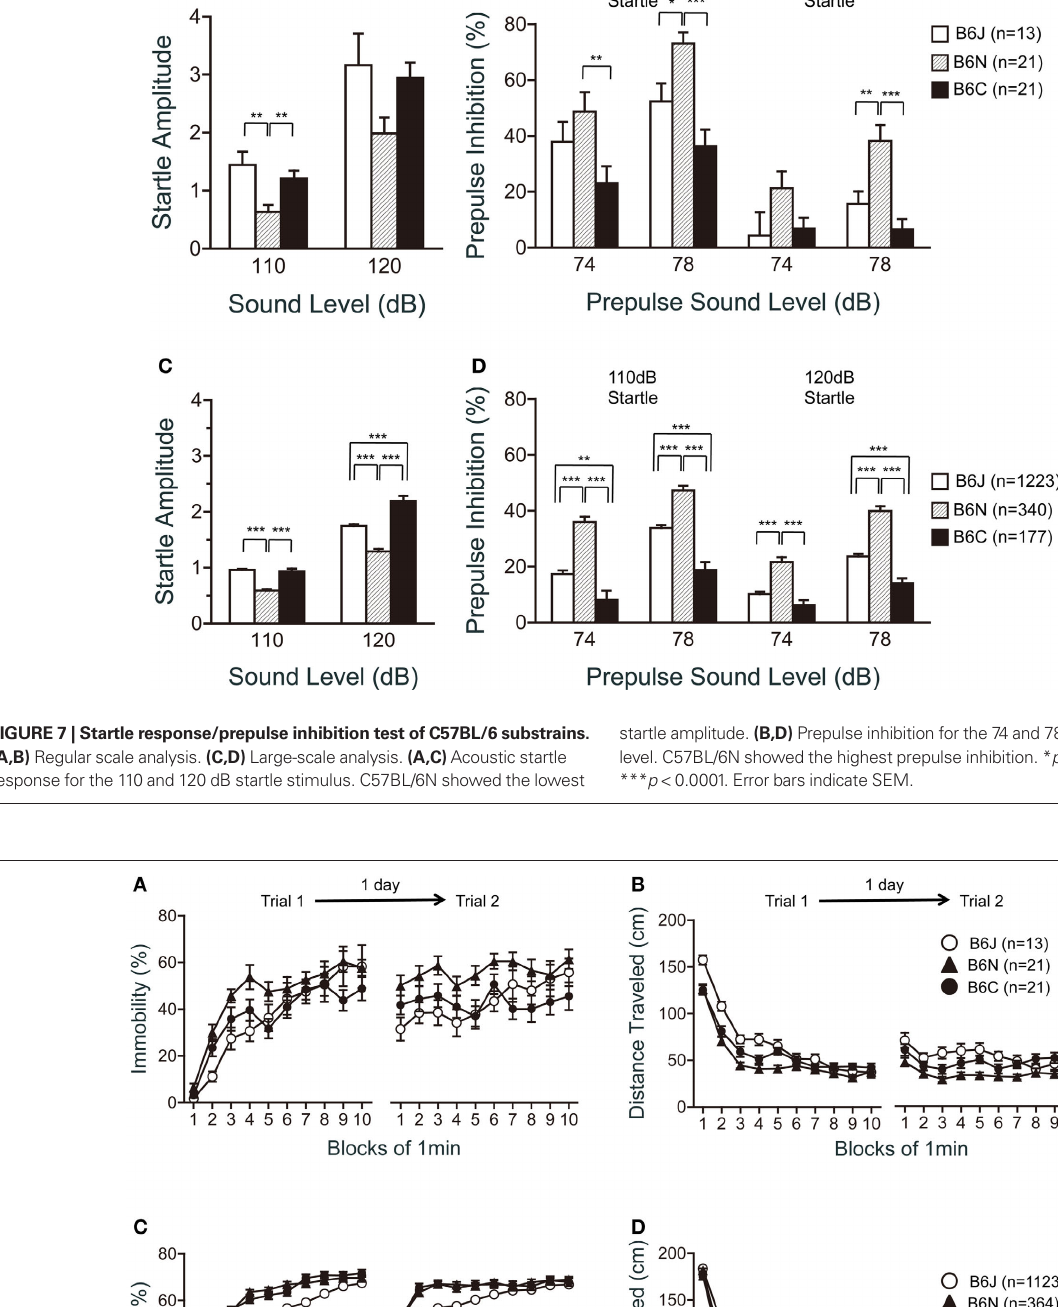
Figure 8 | Porsolt swim test of C57BL/6 substrains. (A,B) Regular scale analysis. (C,D) Large-scale analysis. (A,C) Immobility time (%) in each block for trial 1 and trial 2. (B,D) Total distance traveled in each block for trial 1 and trial 2. Error bars indicate